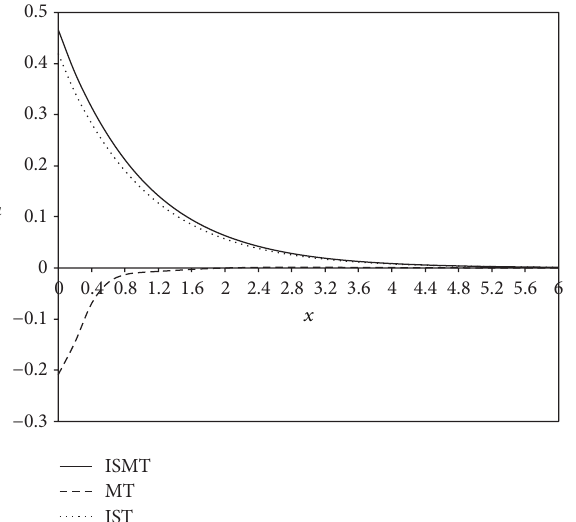
Figure 4: Displacement distribution 𝑢 at 𝛼 = 0.5 , 𝑡 = 0.1 .